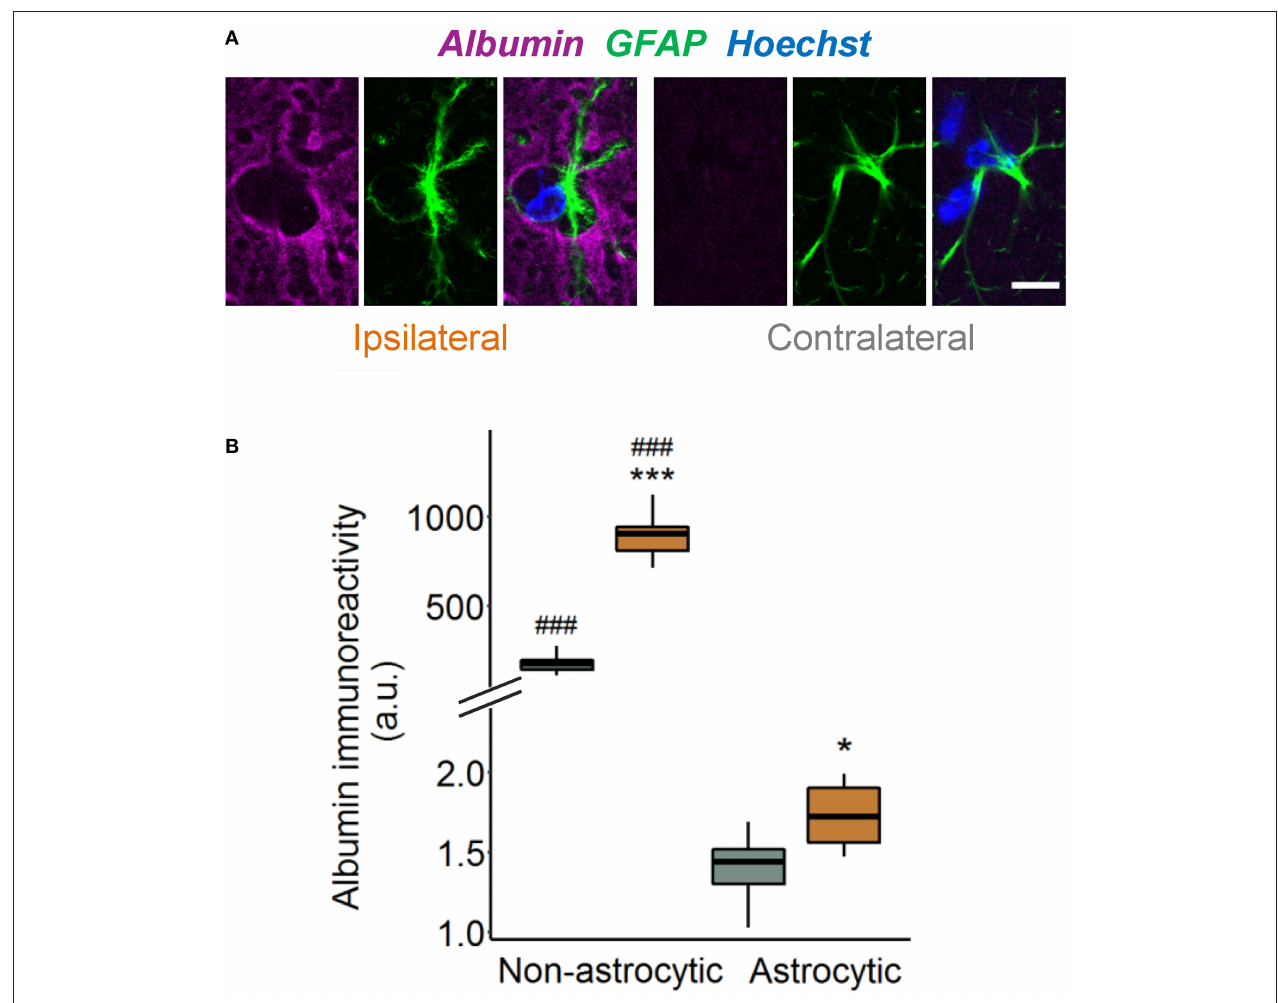
FIGURE 2 | Tiny astrocytic albumin uptake 4h after KA injection. (A) Representative images depicting one focal plane of combined albumin (magenta), GFAP (green), and Hoechst (blue) staining in the hippocampal CA1 stratum radiatum of ipsi- and contralateral slices, 4h after kainate injection. For the purpose of illustration, images are background subtracted and adjusted for brightness. Scale bar: 10 µ m. (B) Albumin immunoreactivity increases in both GFAP-positive and GFAP-negative pixels on the ipsi- vs. contralateral hemisphere, although the increase in astrocytes is orders of magnitude lower than outside the cells. Box plots represent median and quartiles. * p < 0.05, *** p < 0.001 vs. contralateral, ###p < 0.001 vs. astrocytic (two-way ANOVA). N = 9 slices from three mice. au, arbitrary unit.